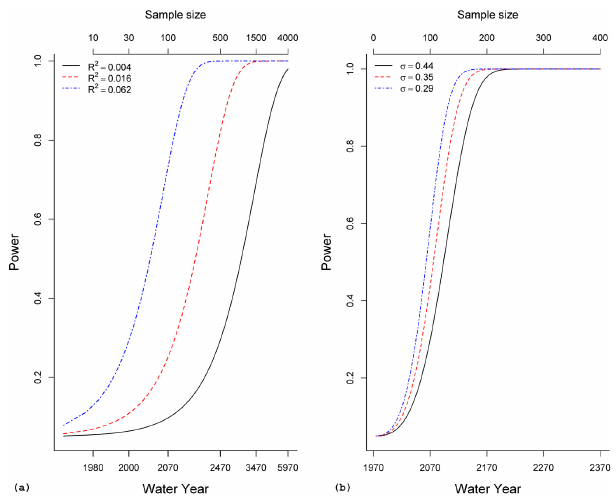
Fig. 13. Power functions for different sample sizes for a test with significance level α = 0 . 05. In the left panel power functions are shown for representative R 2 ; in the right panel power functions for δ = log ( 1 . 2 )/ 85 are shown for representative model residual stan- dard deviations σ